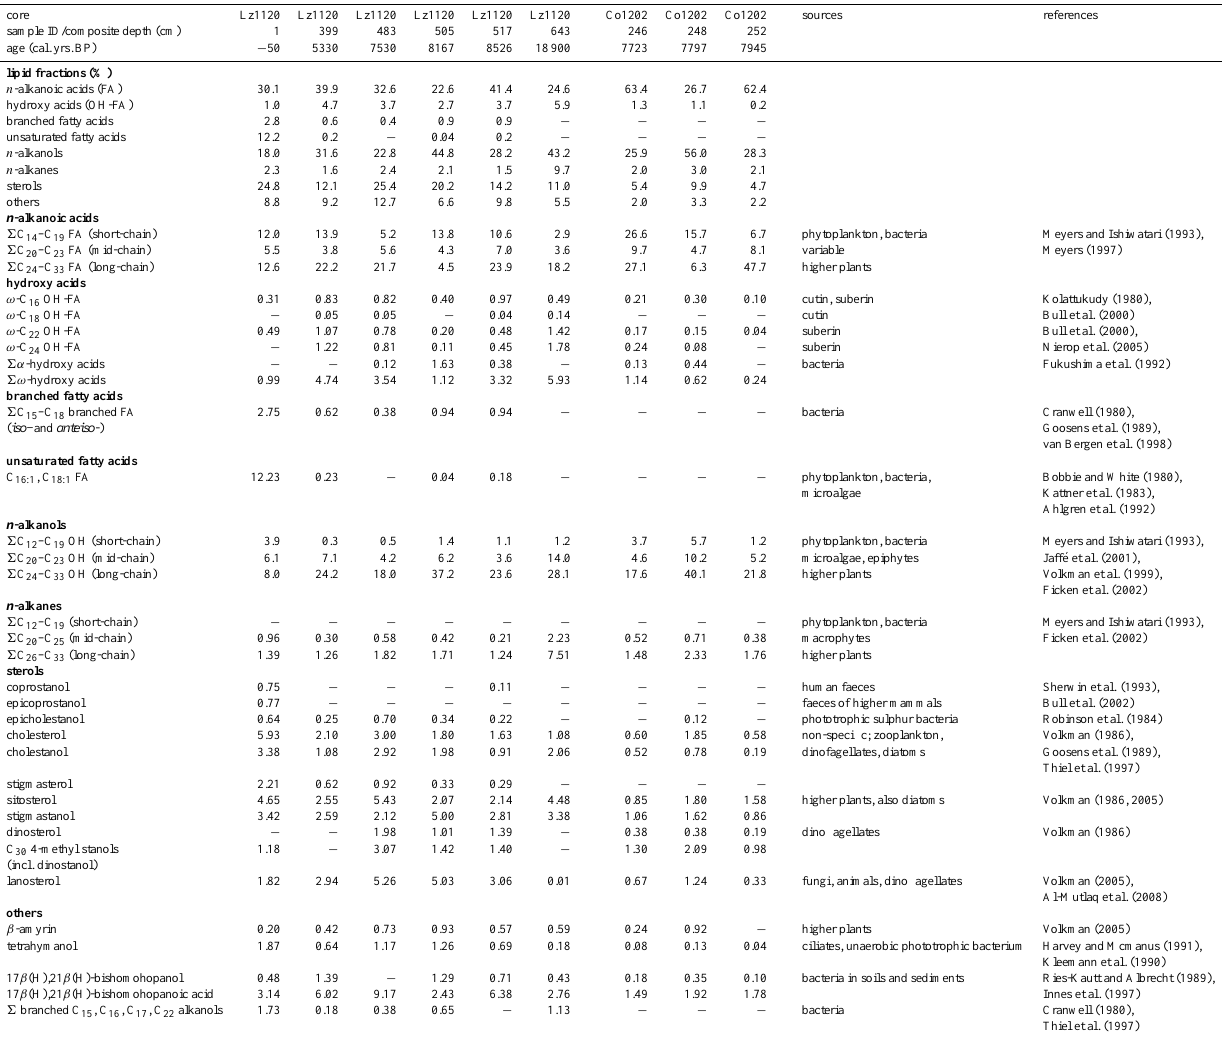
Table 2. Compounds quantified in total lipid extracts from sites Lz1120 and Co1202 as percentages of the total of quantified lipids.